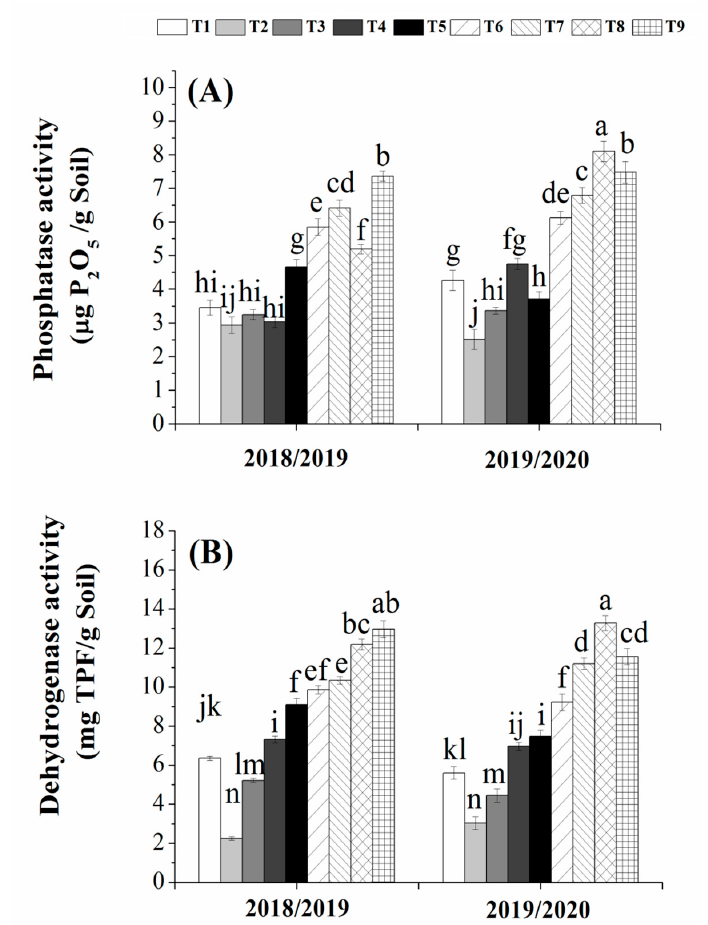
Figure 4. Acid phosphatase ( A ) and dehydrogenase ( B ) activities as affected by organic and/or bio-fertilization. (T1 = 100% NPK, T2 = 50% NPK, T3 = Biogas slurry + 50% NPK, T4 = Humic acid + 50% NPK, T5 = Biogas slurry + Humic acid + 50% NPK, T6 = Biofertilizer mixture + 50% NPK, T7 = Biogas slurry + Biofertilizers + 50% NPK, T8 = Humic acid + Biofertilizers + 50% NPK, T9 = Biogas + Humic + Biofertilizers + 50% NPK). Different letters mean significant difference at p < 0.05.